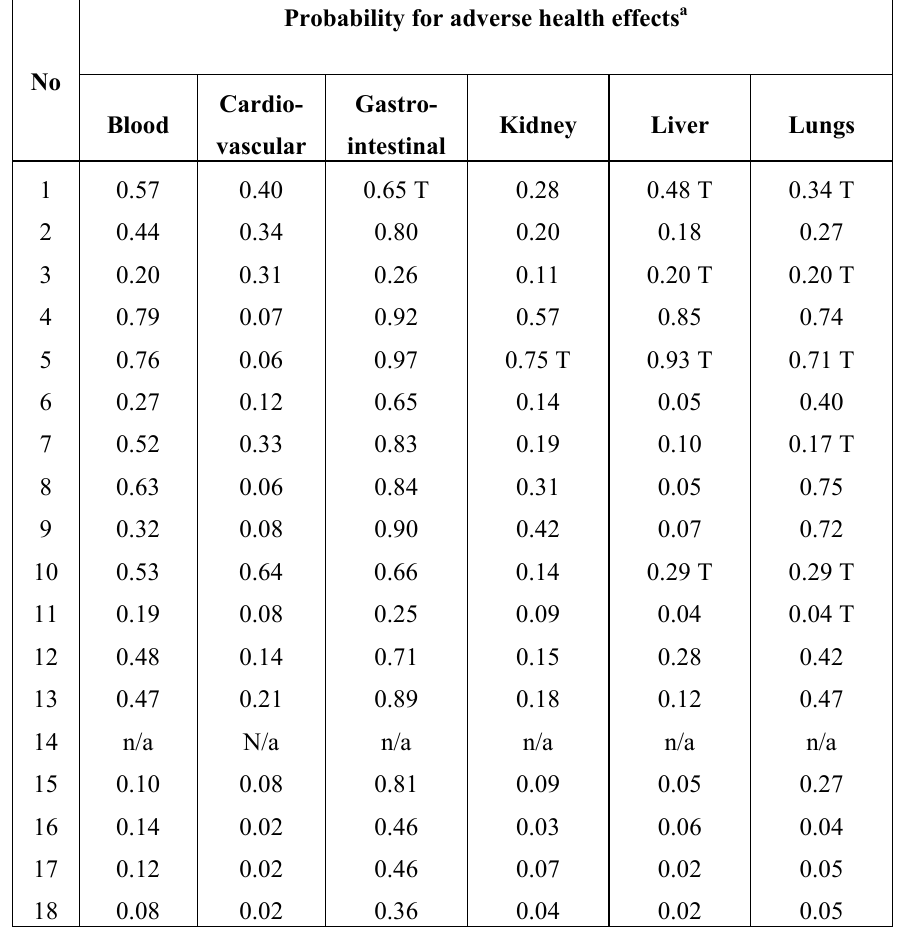
Table 5 . Predicted probabilities for the compounds to exhibit adverse organ specific health effects (n/a denotes that calculated values are not available)